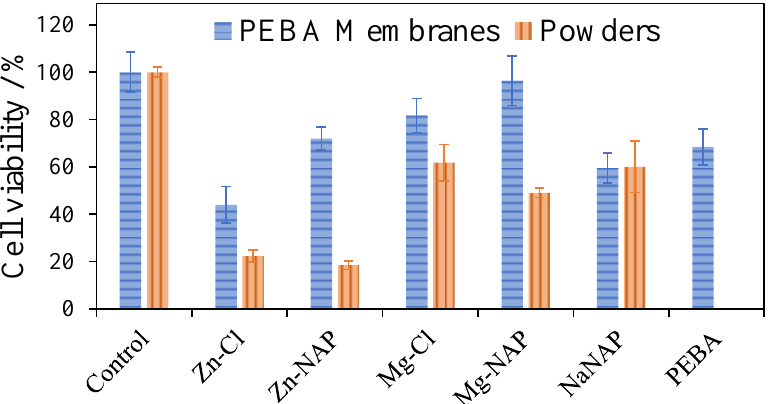
Figure 7. MTT test for NHDF cells in contact with pristine PEBA and PEBA composite membranes containing Zn-Cl, Zn-NAP, Mg-Cl, Mg-NAP or NaNAP particles (in blue–horizontal lines) and powdered samples of Zn-Cl, Zn-NAP, Mg-Cl, Mg-NAP and NaNAP (in orange–vertical lines) for 3 h. Error bars represent standard error (n = 6).